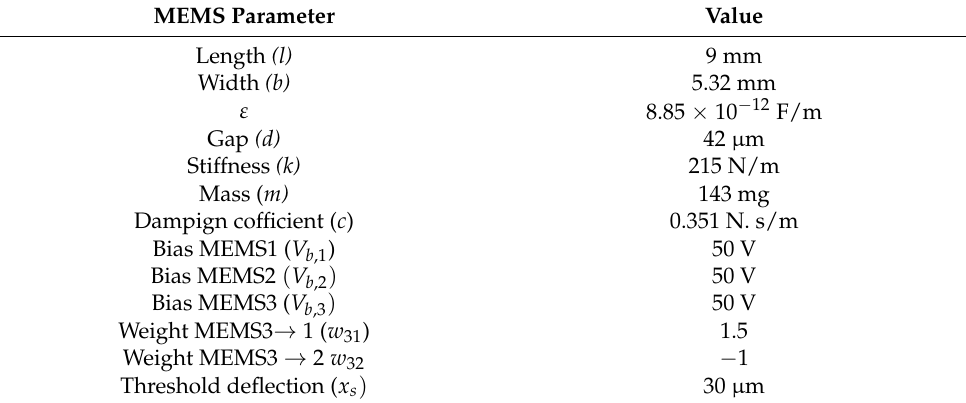
Table 1. MEMS parameters.